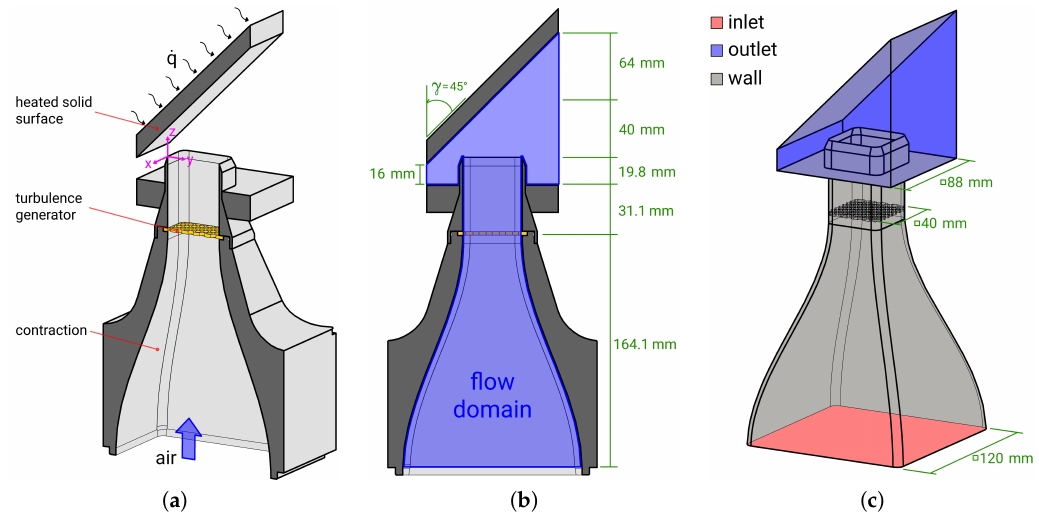
Figure 1. Schematic of the inclined impinging jet configuration. ( a ) trimetric view; ( b ) cutting view at the mid-plane section; ( c ) computational domain and boundaries.